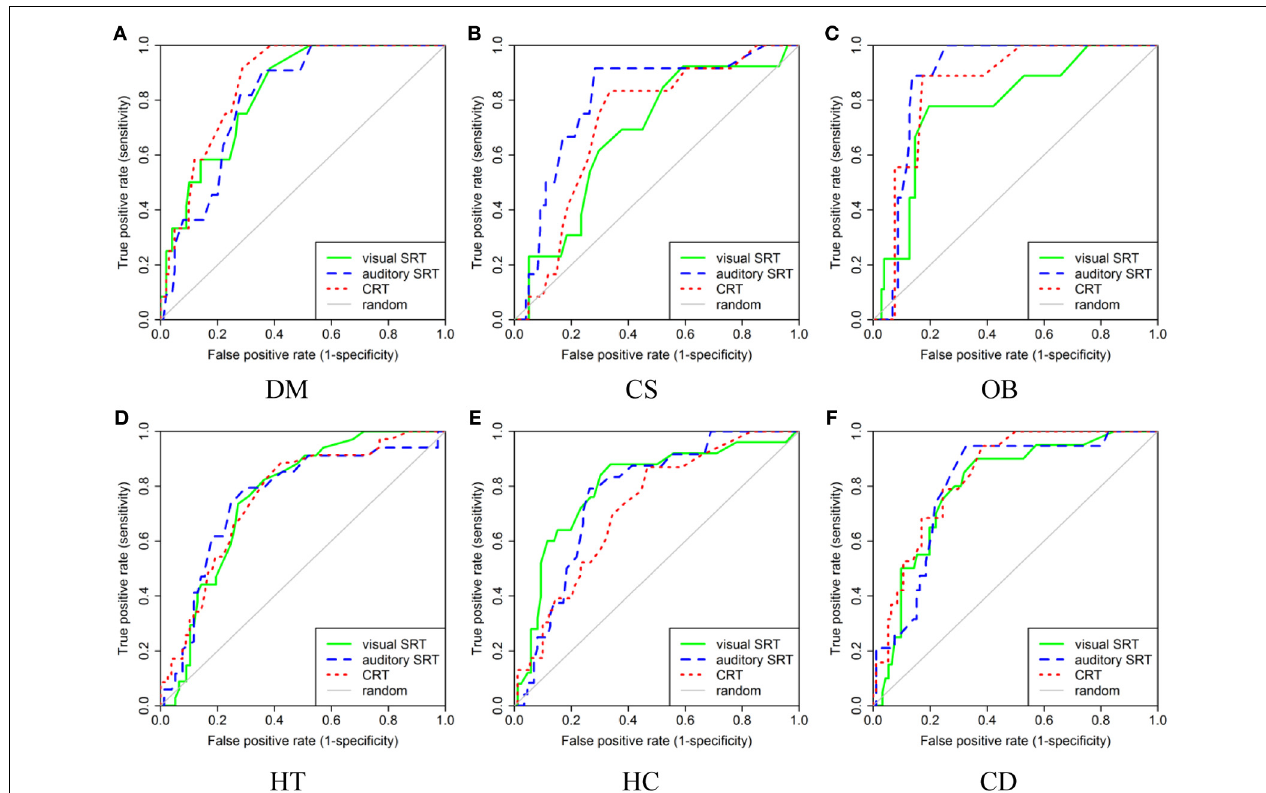
FIGURE 9 | ROC curve for the results obtained in visual SRT, auditory SRT, and CRT task for every risk factor: (A) DM, (B) CS, (C) OB, (D) HT, (E) HC, and (F) CD.